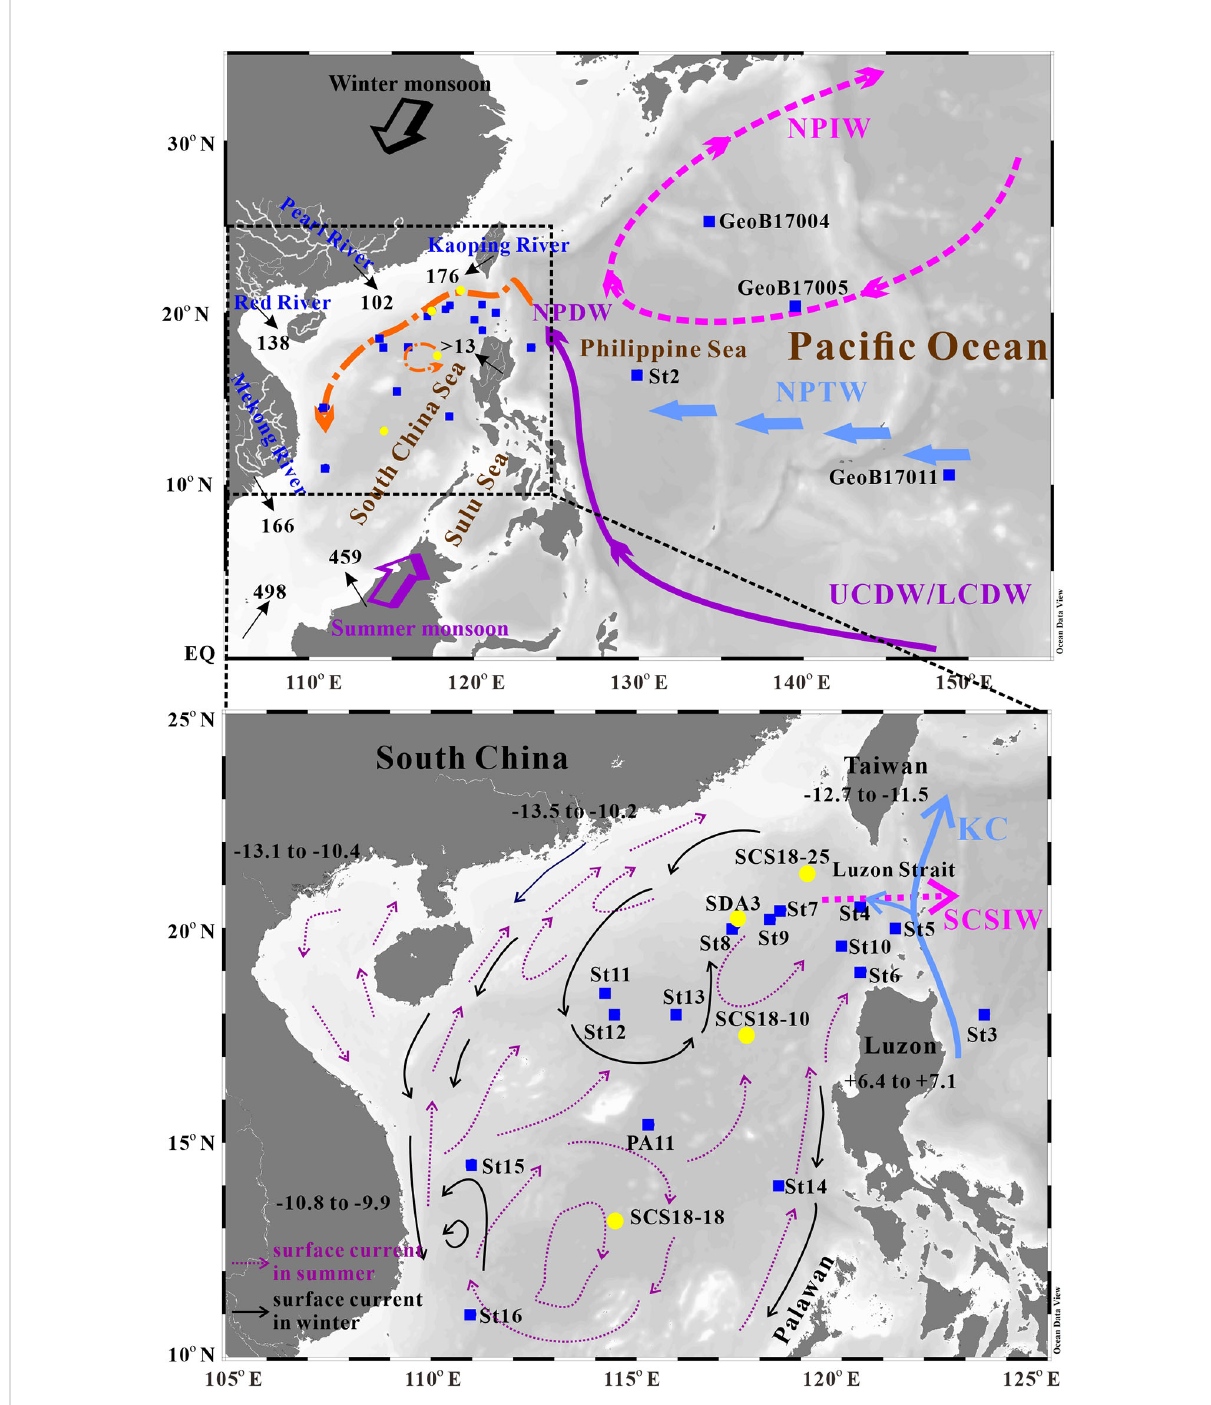
FIGURE 1 Sampling maps showing seawater stations mentioned in text and regional oceanic currents. Black arrows with numbers indicate fl uvial sediment discharges from the surrounding continents (× 10 6 tons/yr; Milliman and Farnsworth, 2011; Liu et al., 2016, and references therein). Yellow dots represent the sampling stations in this study, while blue squares show the stations of published data (Alibo and Nozaki, 2000; Wu et al., 2015; Behrens et al., 2018a). The purple line denotes schematic pathway of the Upper/Lower Circumpolar Deep Water (UCDW/LCDW) in the western Paci fi c Ocean (modi fi ed after Kawabe and Fujio, 2010). The fl ow path of North Paci fi c Intermediate Water (NPIW) is indicated by the pink dashed line (after You, 2003). The North Paci fi c Tropical water (NPTW) is shown by the light blue arrows. The fl ow direction of North Paci fi c Deep Water (NPDW) in the South China Sea is shown by orange dashed lines. The local seasonal reversed monsoon directions are indicated by black and purple arrows. The black line and purple dashed line represent surface circulation in winter and summer, respectively. The map was produced using Ocean Data View (Schlitzer,